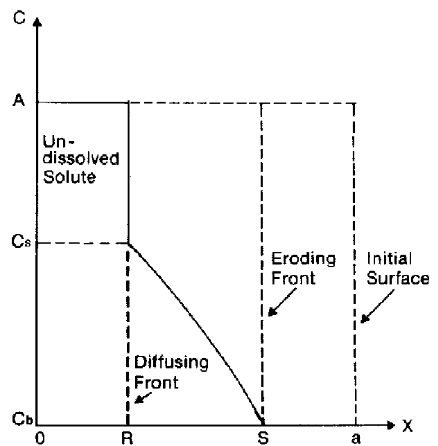
Figure 6. Schematization of a surface-eroding drug-eluting matrix through two moving fronts: An eroding front and a diffusing front. Reprinted from Lee [136] , Copyright 1980 Elsevier.